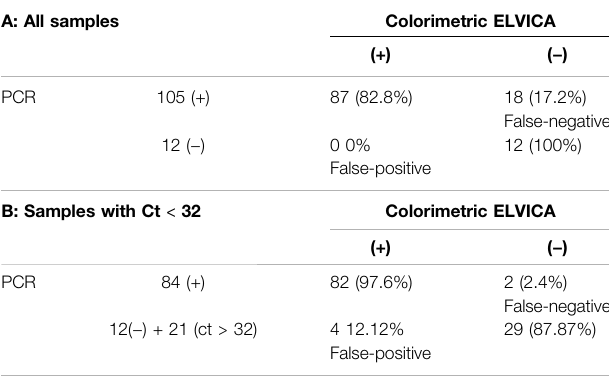
TABLE 1 | Comparison of false-negative and false-positive rates in colorimetric ELVICA for all samples (A) and samples with Ct < 32 (B). (+) and (-) indicate positiveandnegativeresultsofPCRandELVICAtests.SampleswithCt > 32were considered negative in